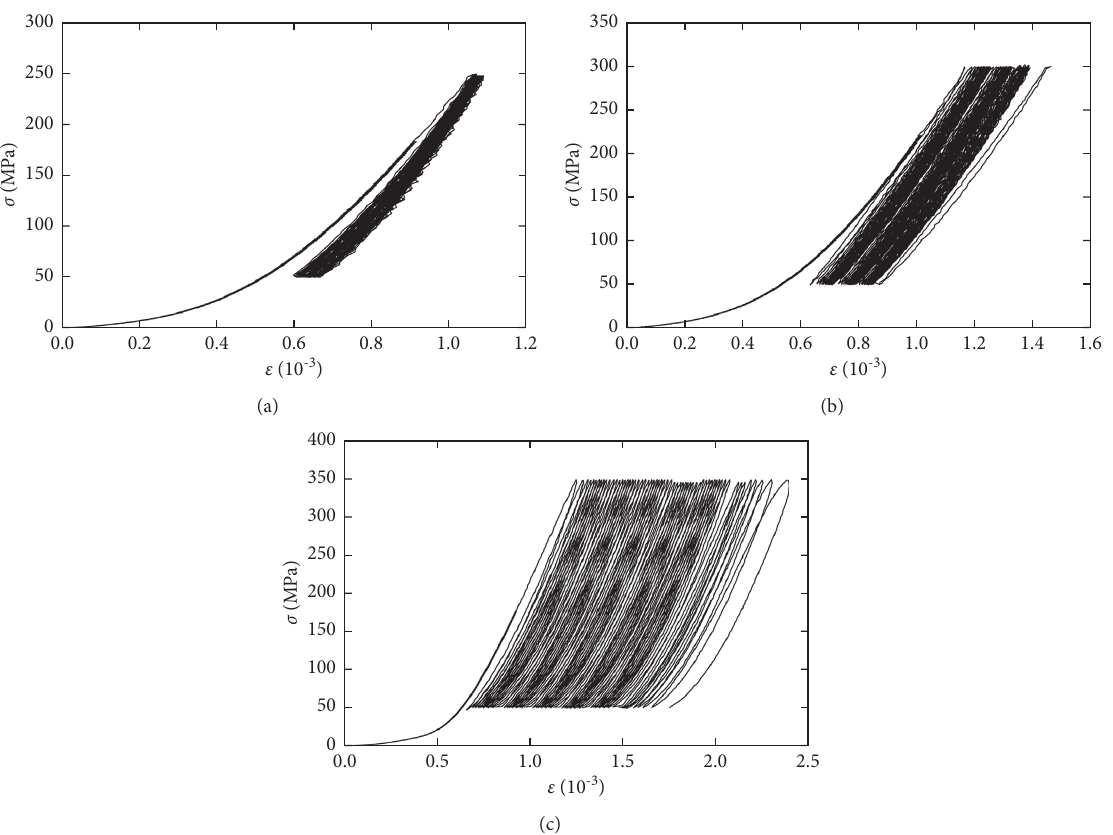
Figure 4: Stress-strain curves of concrete under cyclic loading with different stress amplitudes. (a) σ σ M �